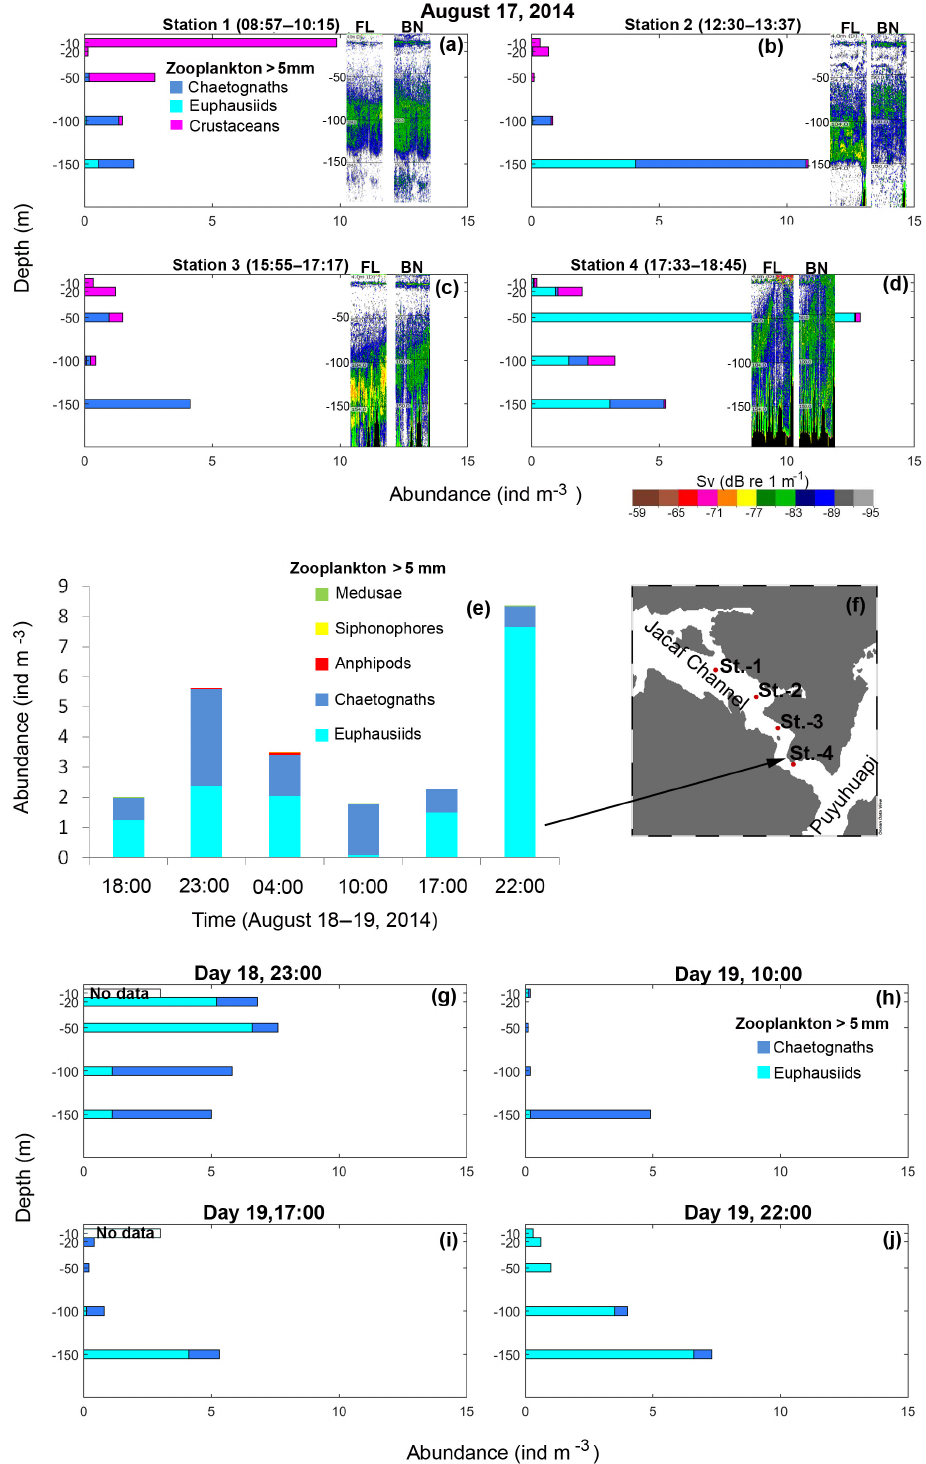
Figure 9. (a–d) In situ stratified zooplankton sampling along Jacaf Channel during 17 August 2014 and the acoustic data collected simul- taneously using the dual-frequency (38 and 120kHz) echo sounder. FL is fluid-like and BN the is blue noise group. (e) Depth-integrated abundance of macrozooplankton groups from surface to 150m depth for various sampling hours. (f) Shows the station positions. (g–j) The vertical abundance of the main macrozooplankton groups found during the wintertime